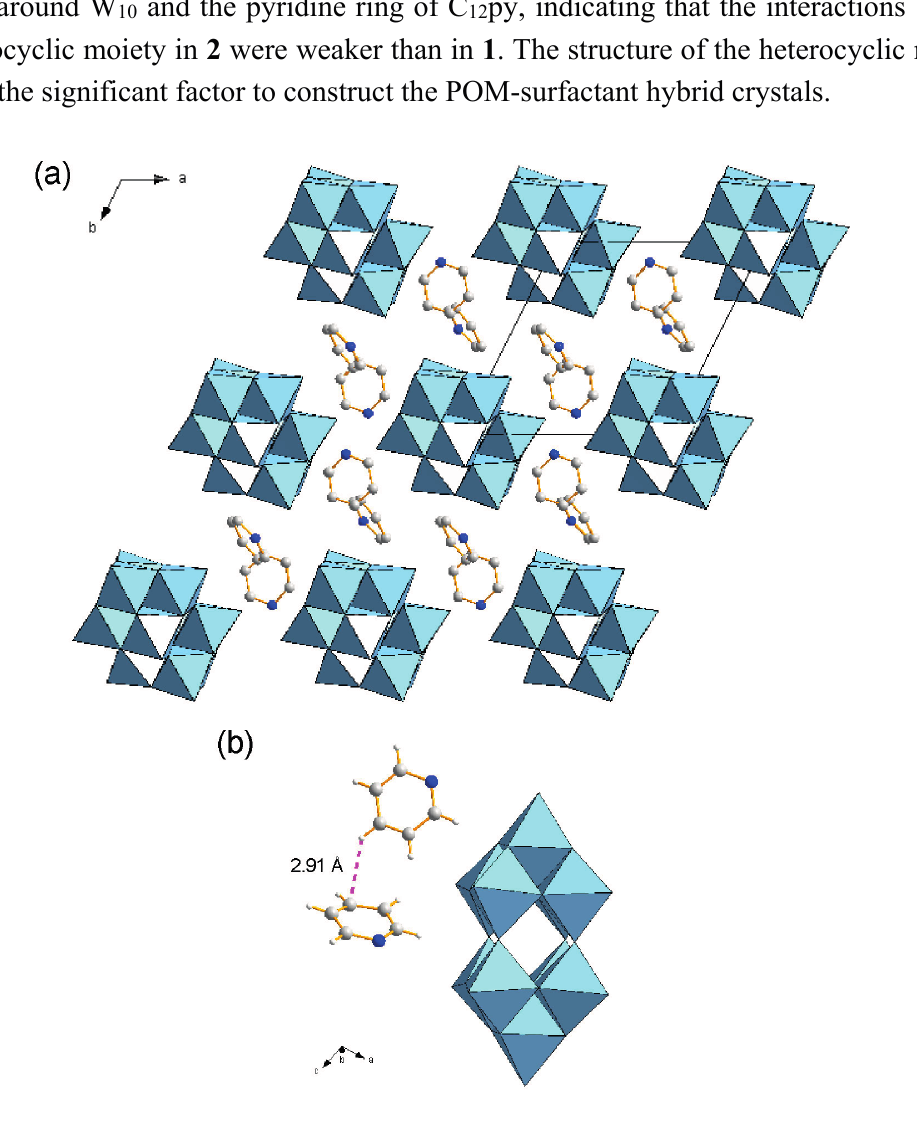
Figure 5. Molecular arrangements in the inorganic layers of 2 (C: gray, N: blue, H: white; W 10 anions in polyhedral representations. The dodecyl groups are omitted for clarity). ( a ) Packing diagram along the c axis. H atoms are omitted for clarity; ( b ) View of crystallographically-independent pyridinium moieties of surfactants in the vicinity of the W 10 anions. The selected short contact is presented as a pink dotted